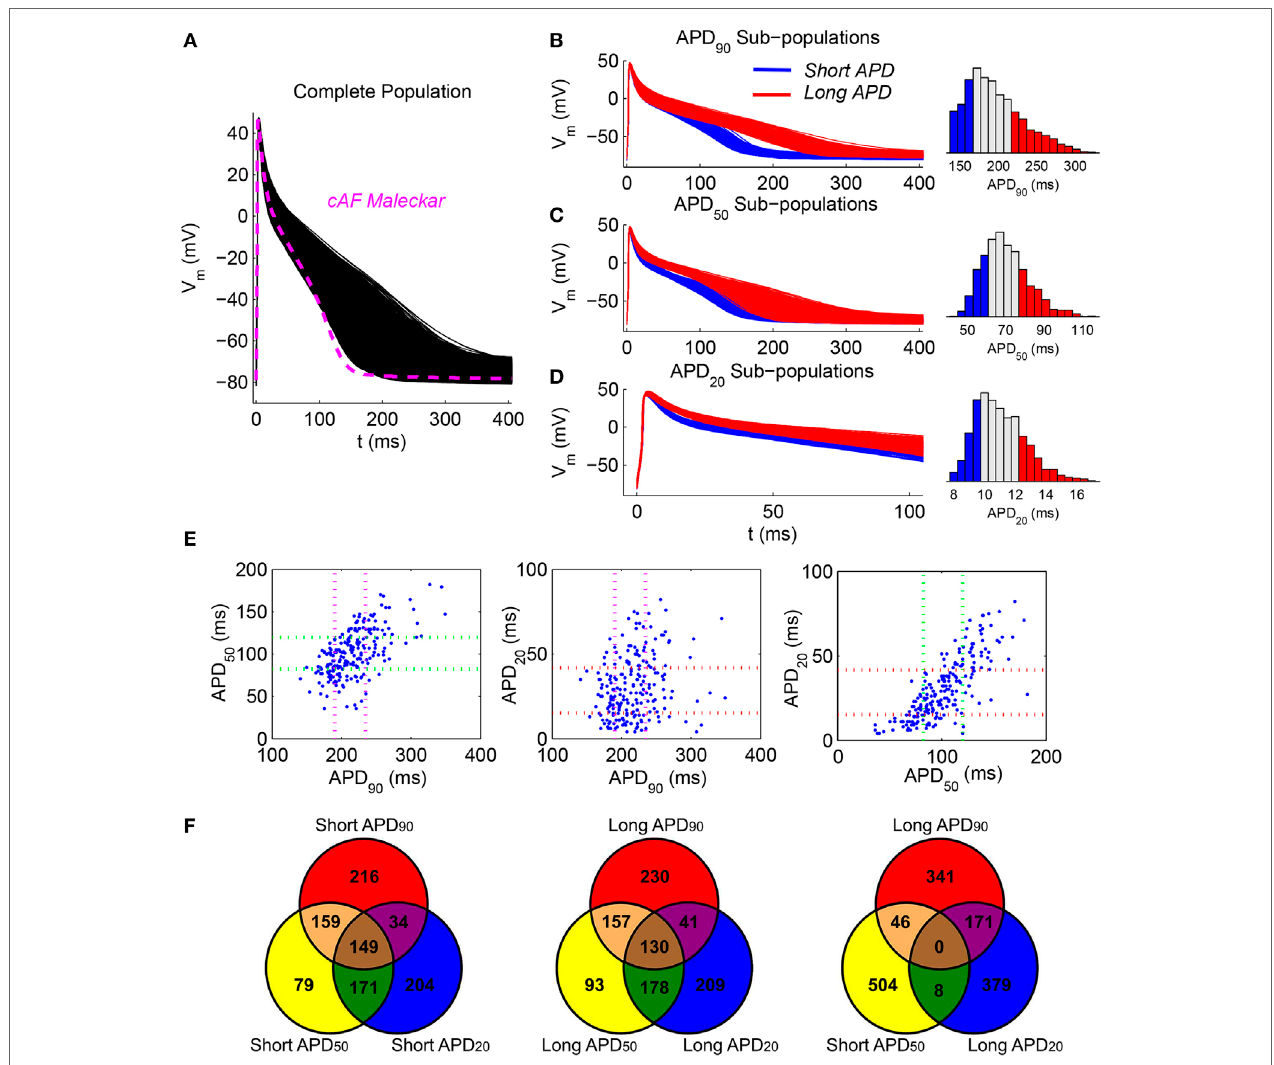
FigUre 1 | considered atrial fibrillation (aF) phenotypes based on cellular repolarization characteristics . (a) Population of simulated AF cell models calibrated against experimental recordings (black). The baseline Maleckar et al. model after chronic-AF remodeling (magenta) is provided for comparison. (B–D) First (blue) and fourth (red) quartile subpopulations according to APD 90 , APD 50 , and APD 20 , respectively, together with the corresponding histograms. Note magnification in time axis in panel (D) . (e) Scatter plots of experimentally measured APD 90 , APD 50 , and APD 20 . Dotted lines represent first and third quartile values for each group of experimental action potential durations (APDs). (F) Venn diagrams with the number of action potential (APs) belonging to one, two, or three subpopulations of models for different intersections of short and long APD